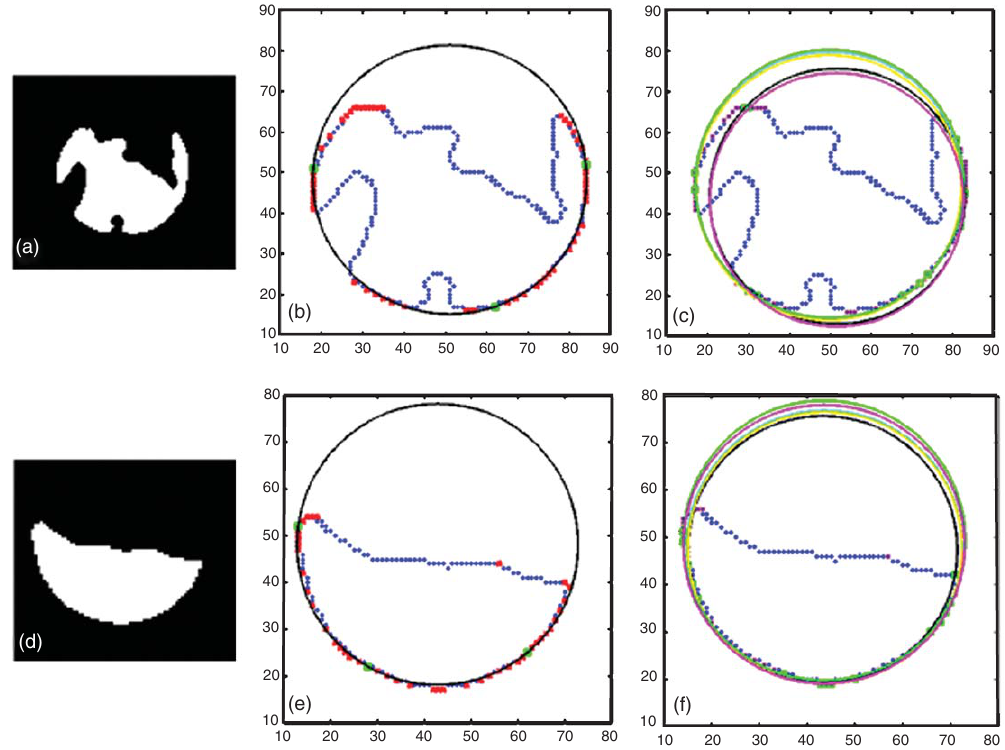
Fig. 4. The circle restoration algorithm (Stage 5) applied over two defective cores. (a)/(d) Object to be reconstructed into a perfect circle. (b)/(e) A single circle reconstructed from three vertices (marked in green squares) chosen randomly from the convex hull which consists of pixels marked in red. (c)/(f) Multiple circles are generated (shown in different colors) by randomly varying the initial three vertices; only the largest of the circles is retained. (Colours are visible in the online version of the article; http://dx.doi.org/10.3233/ACP-2012-0067)